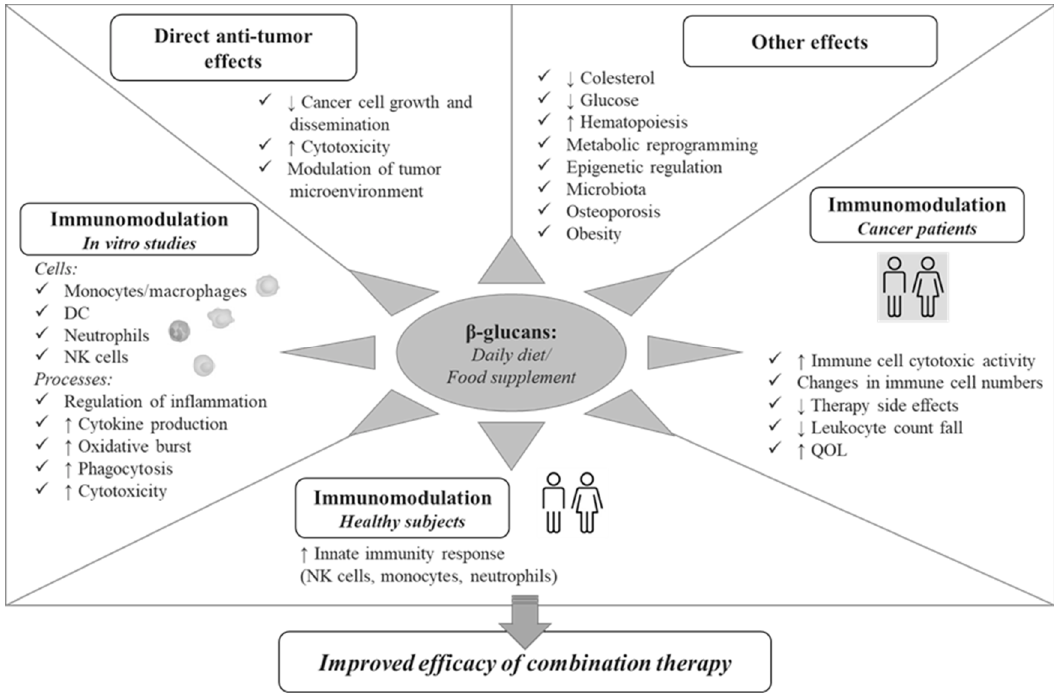
Figure 1 . A schematic representation of the potential role of β -glucan in the control of cancer .